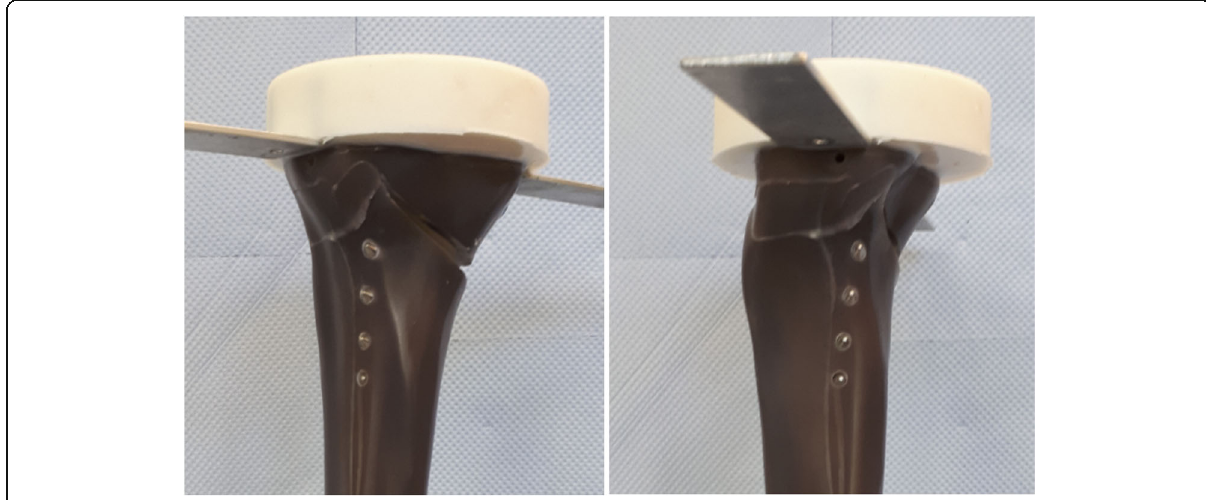
Fig. 2 Fracture of the lateral cortex during static testing (FlexitSystem 1). The opposite cortex appeared to be the weak point of the